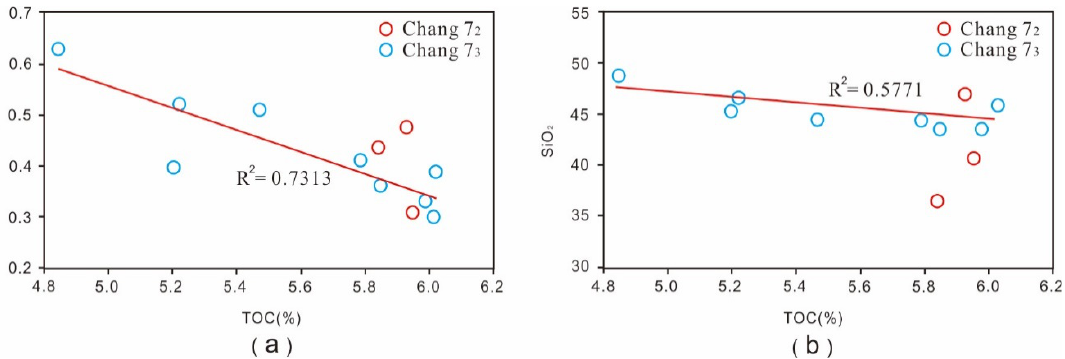
Figure 7. The cross-plot of terrestrial inputs indicators and TOC: ( a ) relationship between TiO 2 and TOC; ( b ) relationship between SiO 2 and TOC.